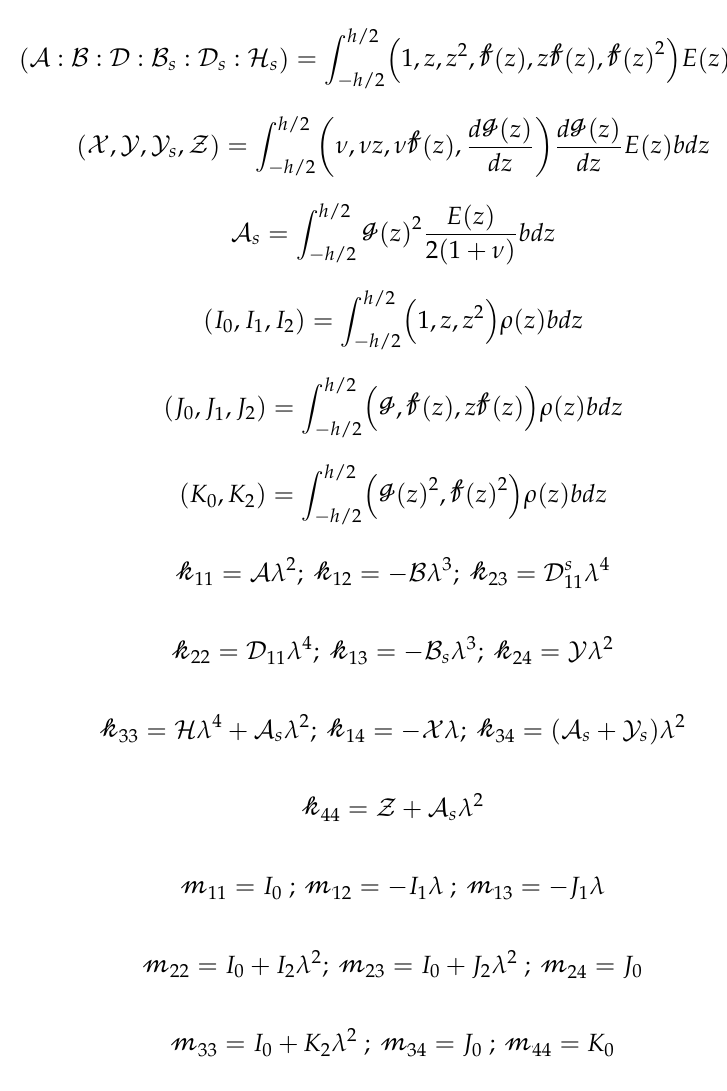
Table 1. Material characteristics of 𝐴𝑙 (cid:2870) 𝑂 (cid:2871) and 𝐴𝑙 [38].